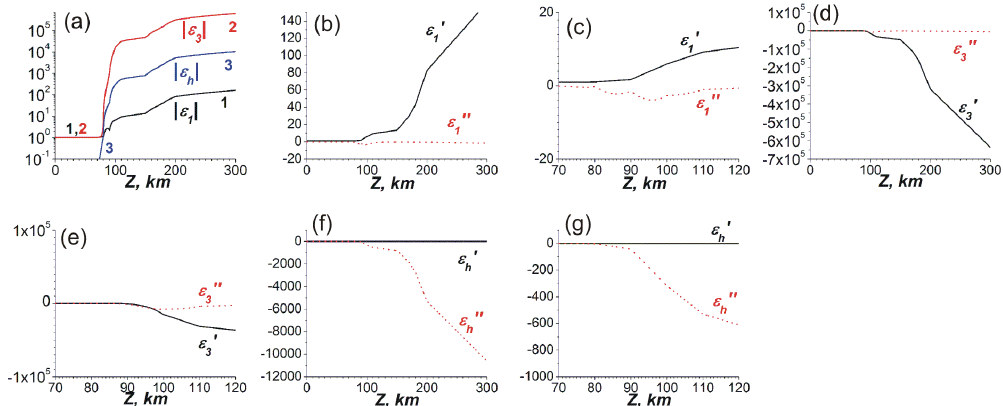
Figure 3. (a) The vertical dependencies of the modules of components of the permittivity in the frame associated with the geomagnetic field | ε | , | ε | and | ε h | with curves 1, 2 and 3, correspondingly. (b) – (g) The real (corresponding lines with the values denoted by one prime) and 1 3 imaginary parts (corresponding lines with the values denoted by two primes) of the components ε 1 , ε 3 and ε h in general and detailed views.